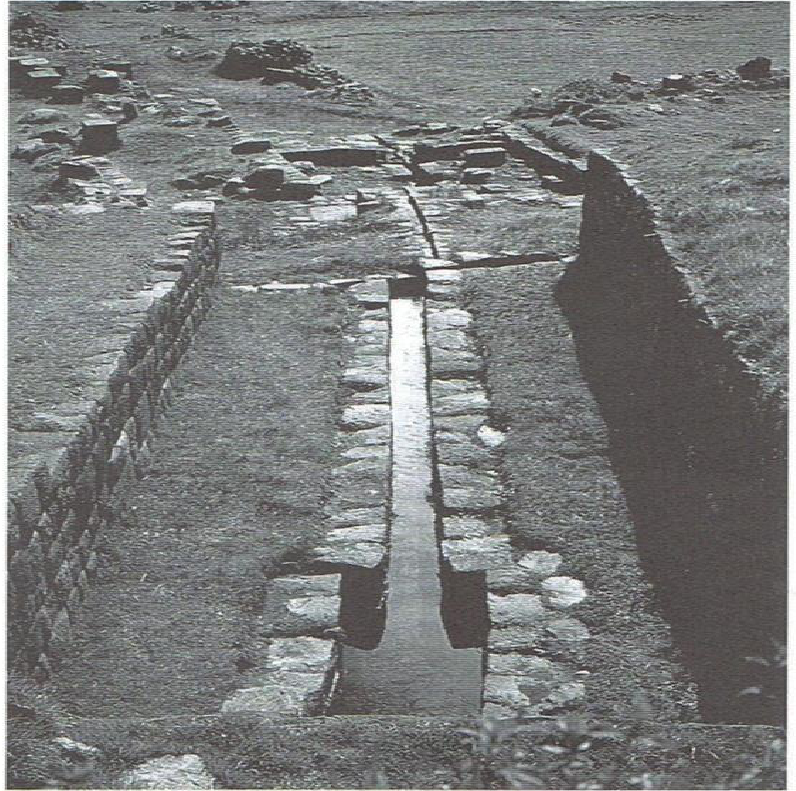
Figure 13. Alternate view of the channel cross section change supplying water to the Waterfall. Transverse surface wave pattern typical of critical flow is apparent in the contracted channel section. This is an alternate view of the water flow pattern channel shown in Figure 11. (Photo by C. Ortloff)